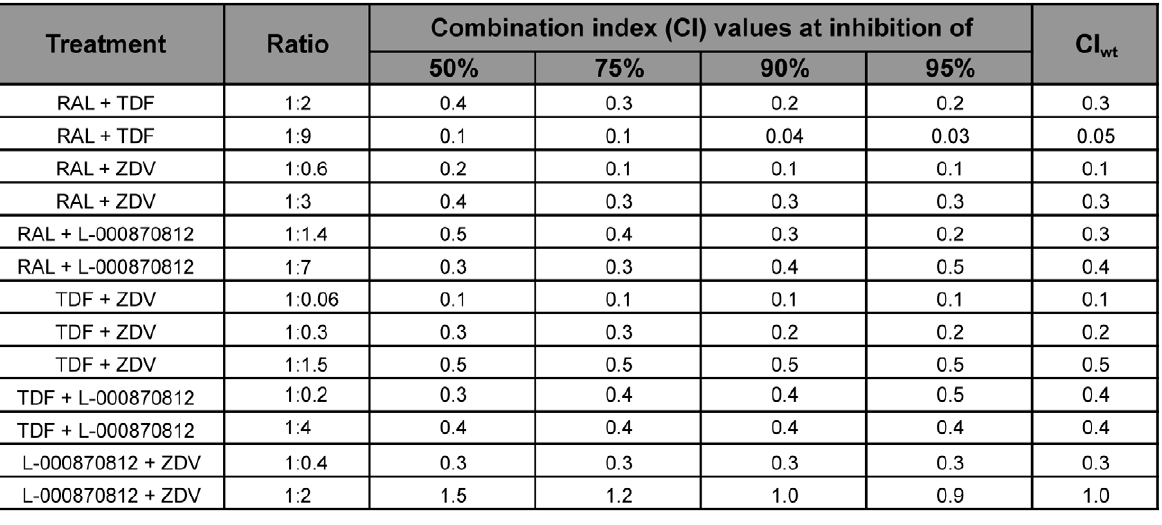
Figure 3. Evaluation of drug-drug interactions against XMRV at 50%, 75%, 90%, and 95% inhibition. Combination Index (CI) values were determined for a mutually exclusive interaction using CalcuSyn program, where CI , 1 indicates synergism, CI=1 indicates additive effect, and CI . 1 indicates antagonism. Weighted average CI value (CI wt ) was assigned as [CI 50 + 2CI 75 + 3CI 90 + 4CI 95 ]/10. RAL, raltegravir; TDF, tenofovir disoproxil fumarate; ZDV,